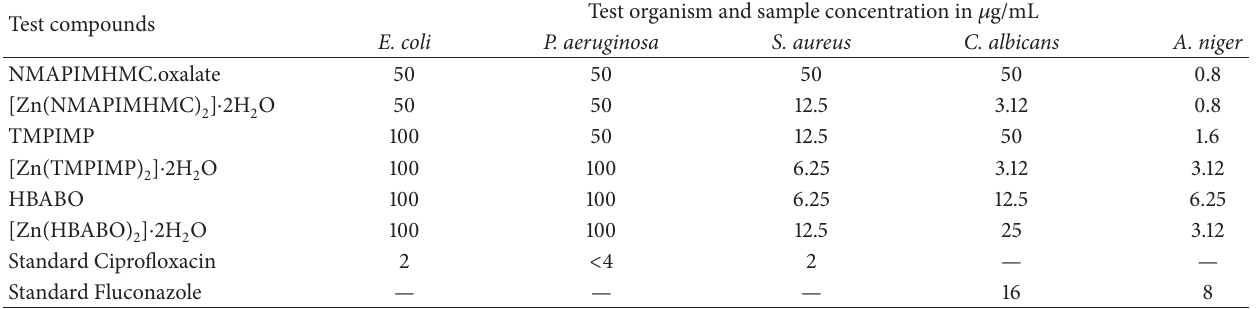
Table 4: Showing comparative antibacterial and antifungal screening results by MIC method. Test organism and sample concentration in 𝜇 Test compounds